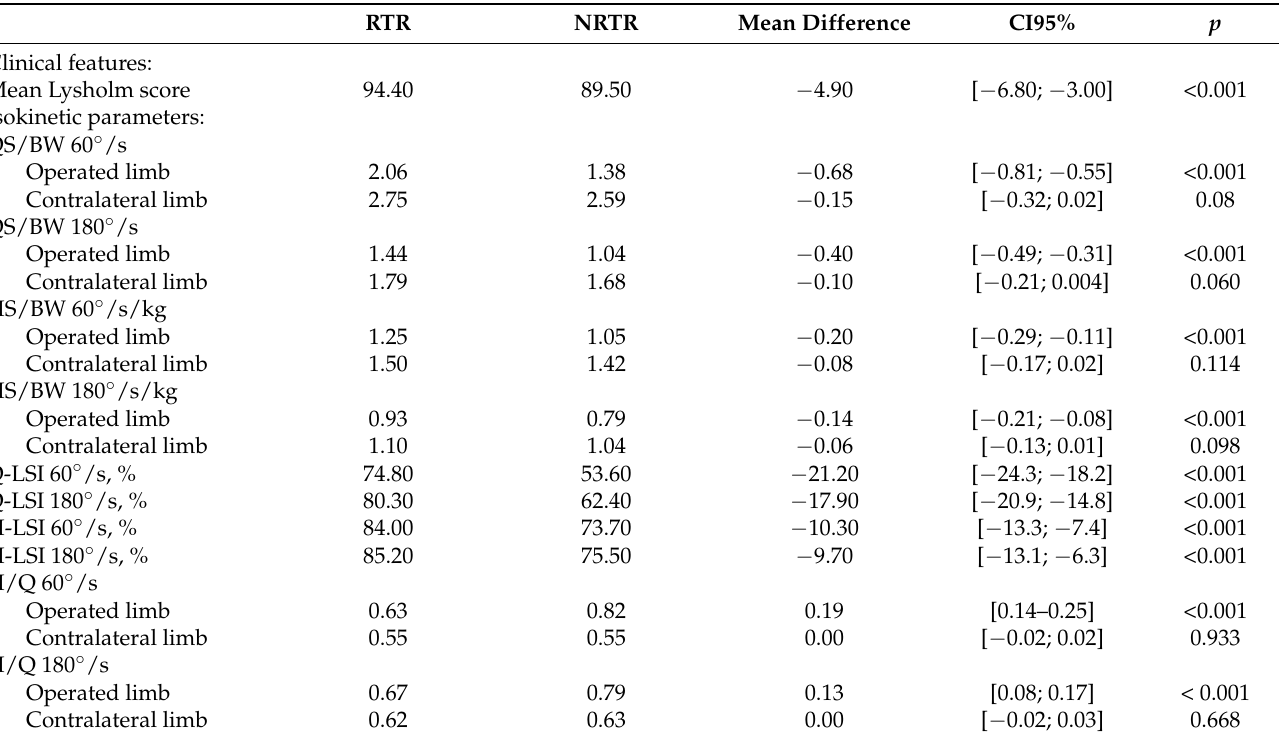
QS/BW: Quadriceps Strength peak torque to Body Weight ratio; HS/BW: Hamstring Strength peak torque to Body Weight ratio; Q-LSI: Quadriceps Limb Symmetry Index; H-LSI: Hamstring Limb Symmetry Index; H/Q: Hamstring-to-Quadriceps ratio; RTR: Return to Running; NRTR: No-Return to